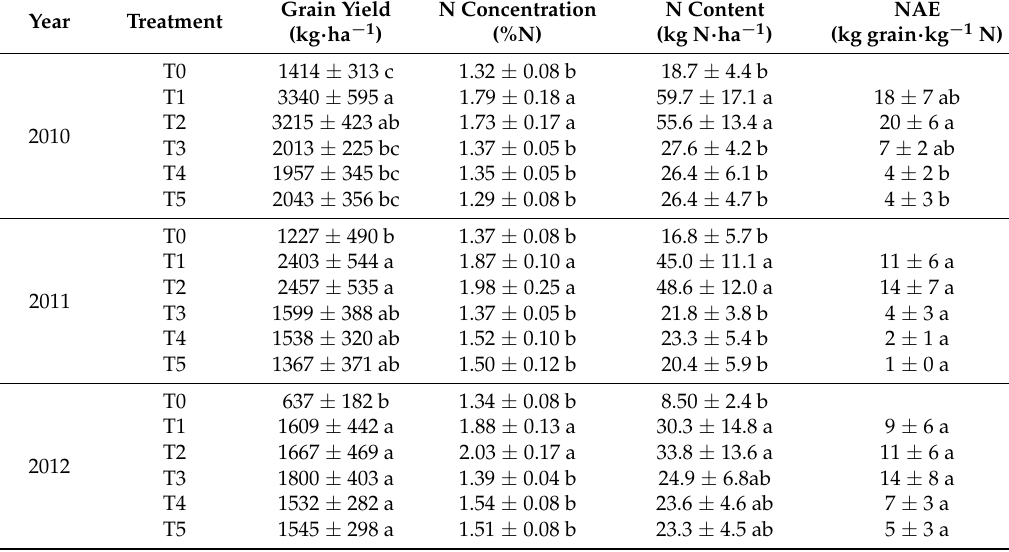
Table 2. Grain yield, grain N concentration and N content, and nitrogen agronomic efficiency (NAE) of the barley crop over the three-year